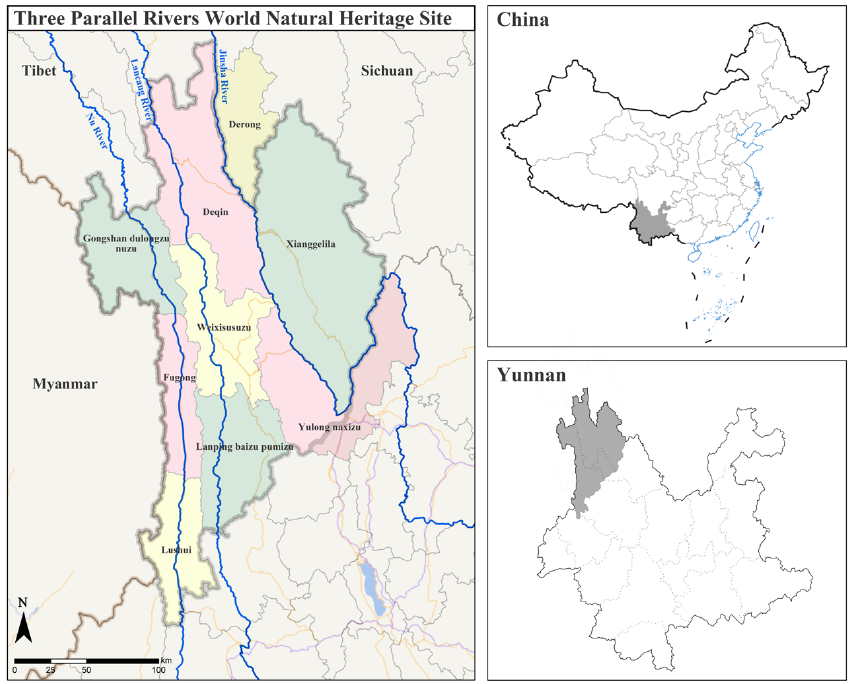
Figure 1. Map of the Three Parallel Rivers Natural World Heritage Site in Yunnan Province, China.